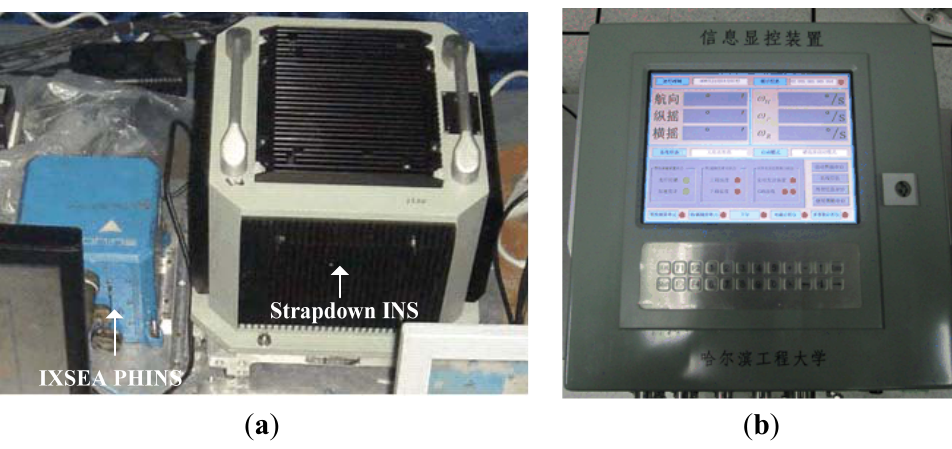
Figure 14. ( a ) Self-made strapdown INS, PHINS; ( b ) Information control